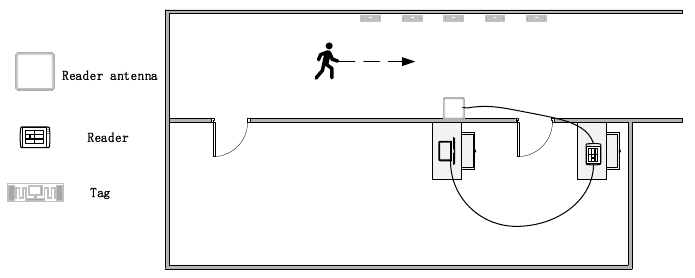
Figure 10. Experimental